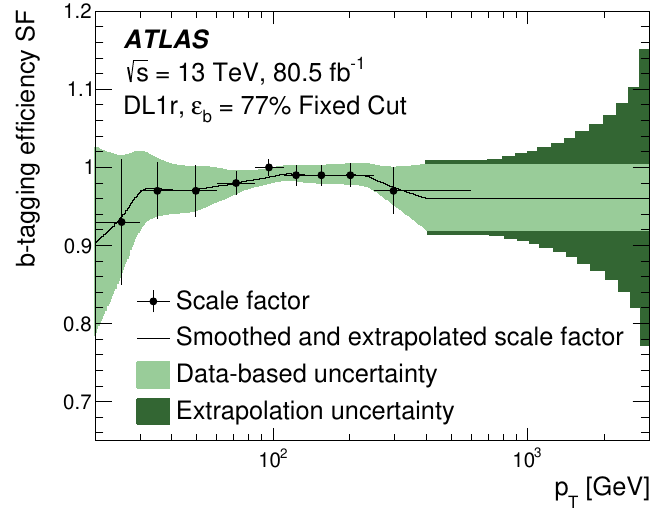
Figure 1 . Simulation-to-data scale factor as a function of jet p the DL1r b -tagging algorithm. The scale factors are measured with a likelihood-based method in a sample highly enriched in tt events using 2015{2017 data, as described in ref. [60], with uncertainties due to the limited size of data sample, detector calibration and physics modelling. An additional uncertainty is included to extrapolate the measured uncertainties to the high- p ( p > 400 GeV), and has contributions related to the reconstruction of tracks and jets, the modelling T of the b -hadrons and the interaction of long-lived b -hadrons with the detector